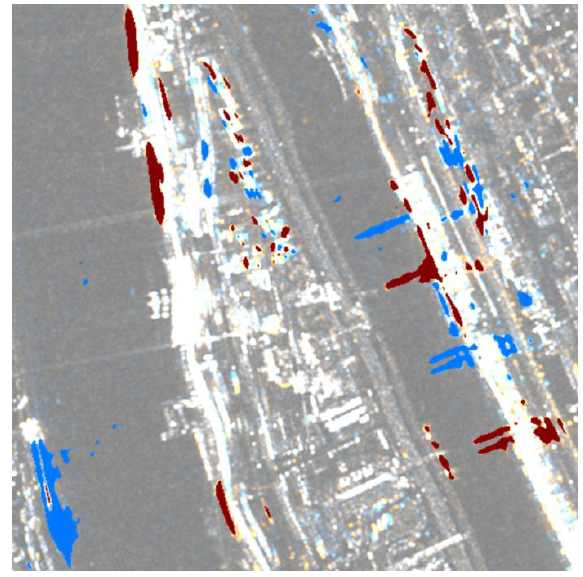
Figure 16. Mode of the five manually derived references for the change in